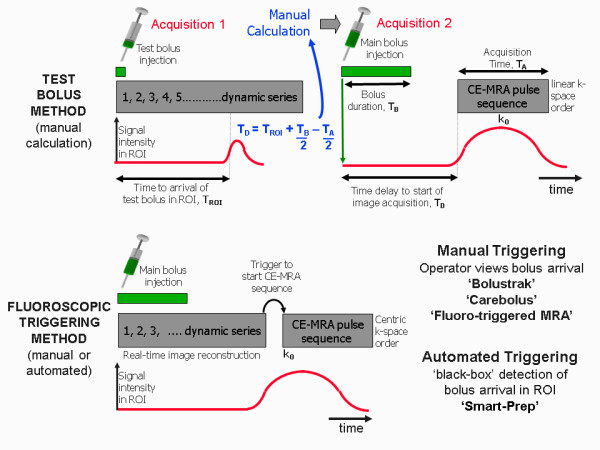
The two principle methods used for timing of the start of the CE-MRA data acquisition. For the test bolus method (top) a small bolus (1-2 ml) of contrast agent is first injected and a single-slice acquisition is used to acquire a dynamic series of images at approximately 1 second intervals in the region of interest (ROI). The image time series is analysed to determine the time at which the contrast bolus arrived in the ROI, TROI. The time delay TD for the CE-MRA acquisition is then manually calculated taking into account the time duration of the bolus, TB, the acquisition time of the MRA pulse sequence, TA and the k-space order (in this case linear). For the fluoroscopic triggering method (bottom) the first acquisition acquires a dynamic series of images at approximately 1 sec intervals which are reconstructed in real time to allow detection of contrast arrival. On detection of bolus arrival, a trigger signal is generated either manually or automatically that causes the acquisition to switch to the CE-MRA pulse sequence. Manual triggering requires the operator to view the dynamic series of images in real time and to initiate the trigger once they judge that the contrast bolus has adequately progressed into the region of interest. Automated triggering monitors the signal intensity within a region of interest predefined by the operator on the dynamic image data set. The trigger signal is generated once the signal intensity rises above a threshold value.